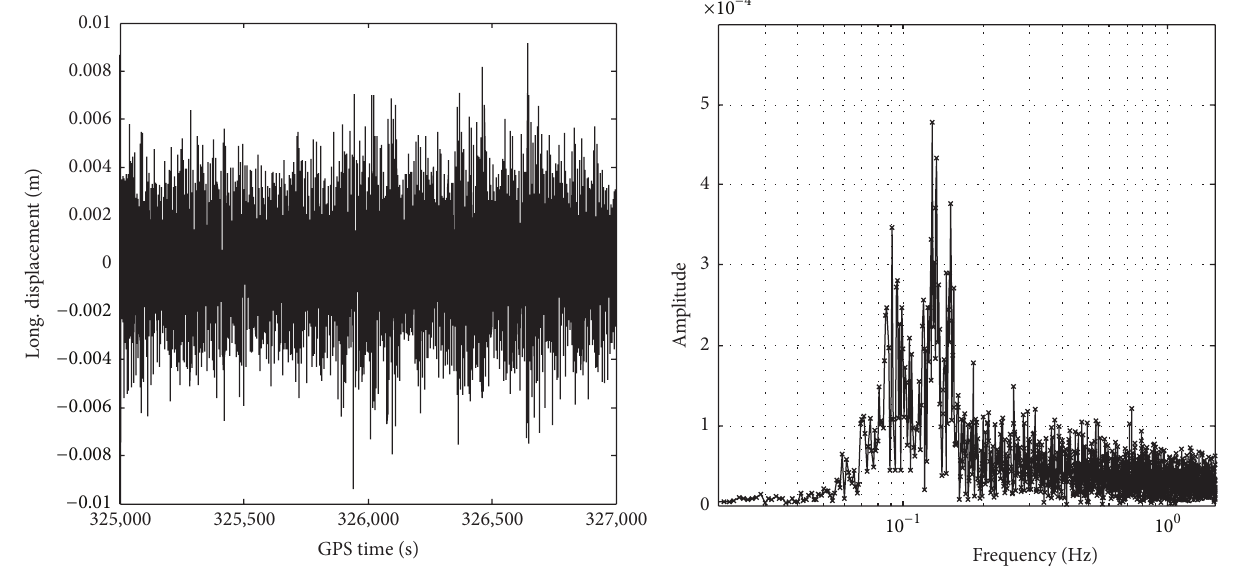
Figure 18: The filtered longitudinal displacements and corresponding frequencies during the wind speed decreasing